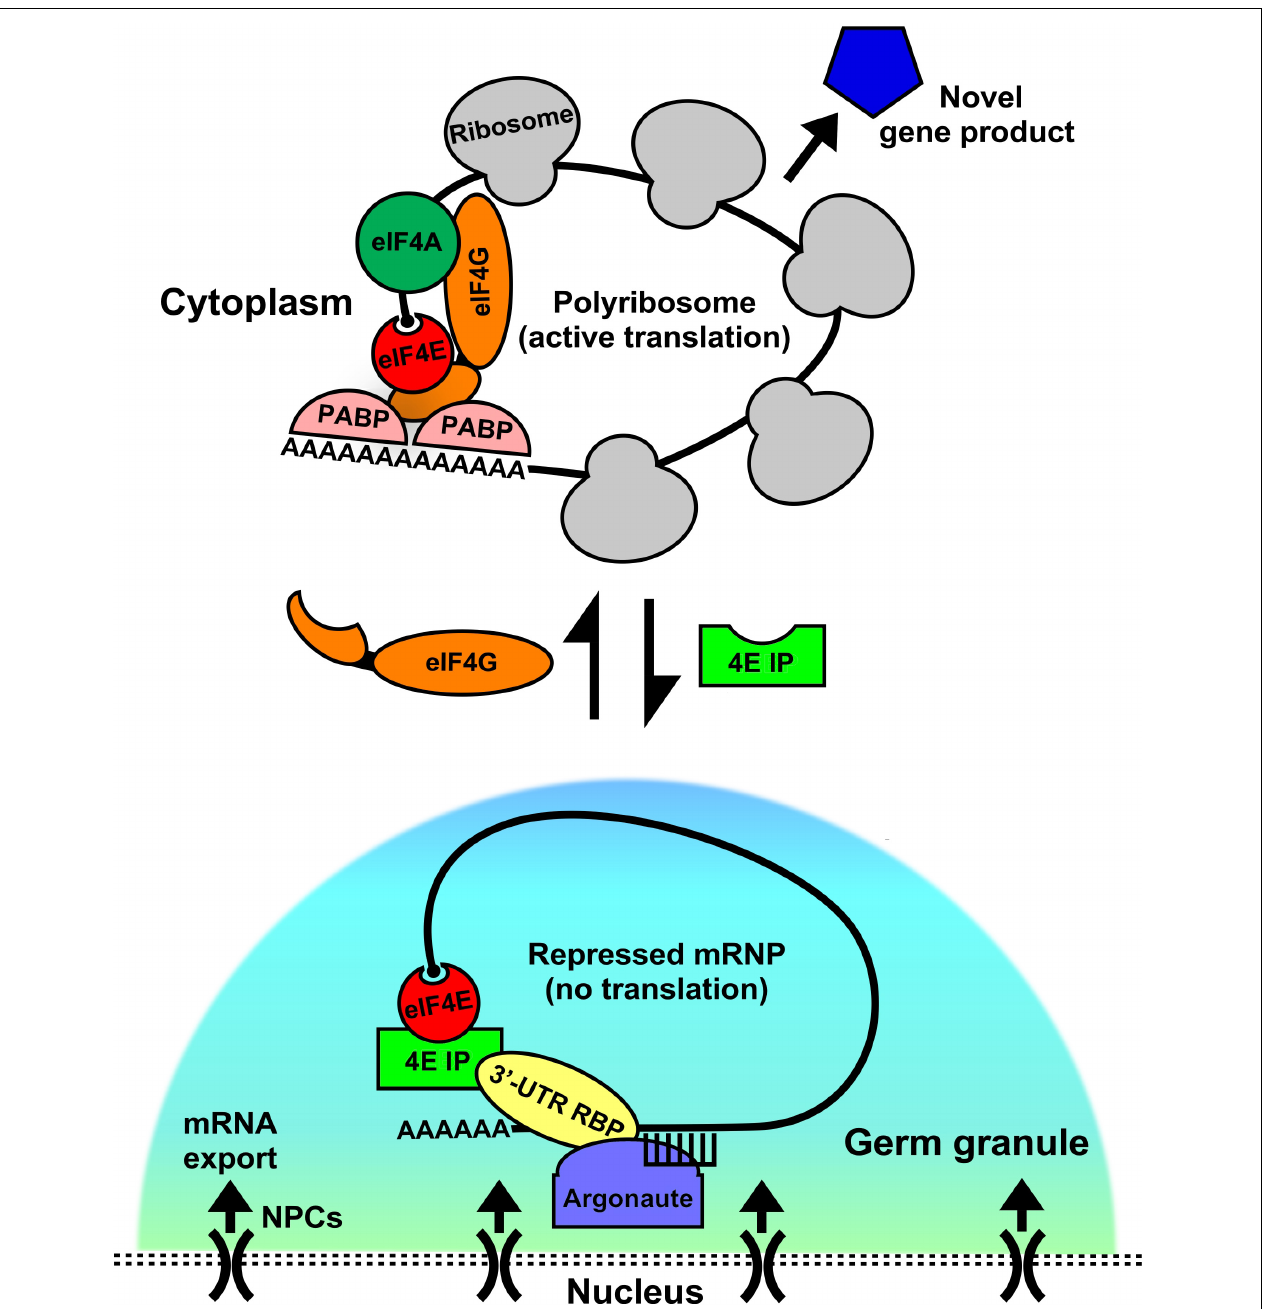
FIGURE 1 | Germ granules as assembly sites for eIF4E:4EIP mRNP complexes to direct repression and activation of translation. In germ cells, mRNAs are exported out of the nucleus through the nuclear pore complex (NPC). As they exit they come under control by the germ granule environment. These conserved perinuclear structures act as hubs of post-transcriptional gene regulation, where they act as sites for the assembly and remodeling of diverse messenger ribonucleoprotein complexes (mRNPs). Germ granules are primarily sites of translational repression, as they do not contain ribosomes. However, recent evidence suggests that both repression and activation events may be set up here as a manner of mRNA sorting or licensing. Translation factors like eIF4E reside in complexes both within (repressed) and outside (activated) of the granule, potentially giving it a dual role. When eIF4E is in germ granules it binds to its cognate eIF4E-interacting protein (4EIP) in a complex with sequence specific 3 (cid:48) -UTR binding proteins. This complex prevents cap-dependent translation initiation by preventing eIF4G binding to eIF4E. Little is known about how the “decision” to activate translation is made, but our models suggests that a handoff from the granule to the cytoplasm occurs by mRNP remodeling. 4EIP is displaced by eIF4G and leads to initiation and recruitment to polyribosomes. Other factors participate in the repression to activation switch, like helicases (eIF4A, VASA, etc.) that unwind mRNA secondary structure, poly(A) polymerases (PAP) that extend 3 (cid:48) -poly(A) tails, and poly(A)-binding protein (PABP), which both protects transcripts and enhances translation via its interaction with eIF4G. Activating a repressed mRNP is the first step in producing novel gene products that can dictate the fate and function of germ cells.